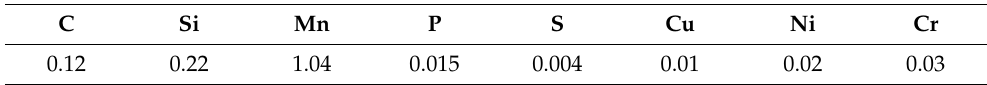
Figure 2. Microstructure of the steel used in this study: ( A ) upper surface and ( B ) side surface of an as-received steel plate. Note: TD—thickness direction, ND—normal direction, and RD—rolling direction. Table 1. Chemical composition of the steel (mass%), which was provided by the manufacturer.